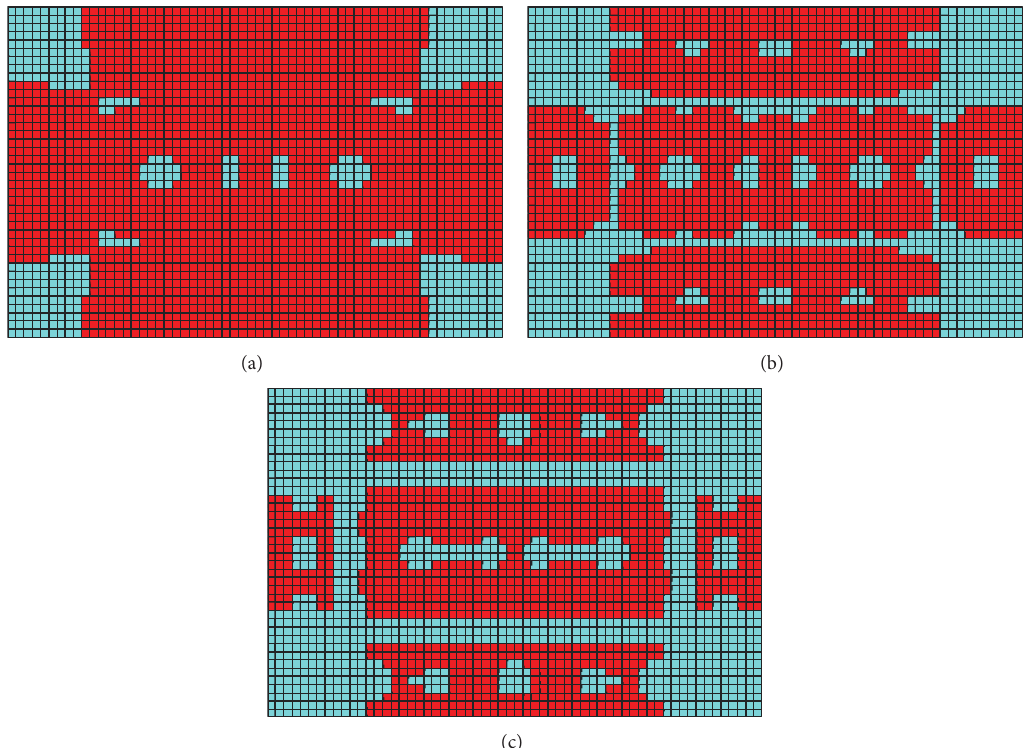
Figure 11: Topology evolving process using improved sensitivity analysis. (a) Iteration 14 (rejection ratio 17.5%). (b) Iteration 28 (rejection ratio 35%). (c) Iteration 40 (rejection ratio